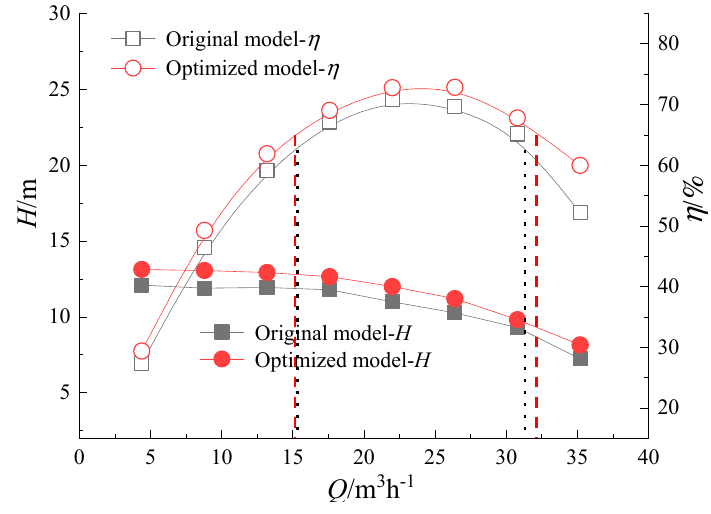
Figure 11. Performance curves of optimized impeller and original impeller.